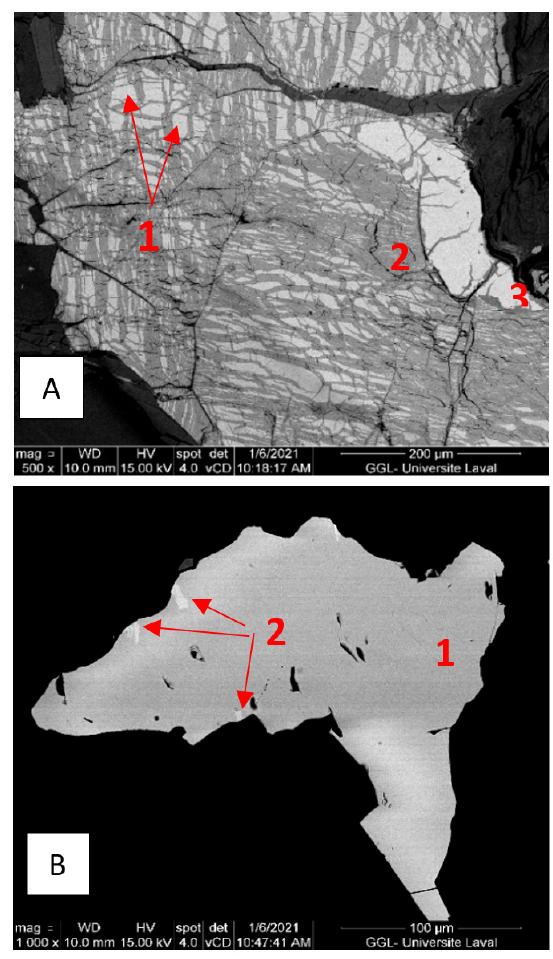
Figure 4. Secondary electron (SE) images of the sulfide from the Connecticut concrete sample. A) Strongly oxidized pyrrhotite grain. 1. pyrrhotite 2. ferrihydrite, 3. chalcopyrite. B) Pyrrhotite grain with pentlandite flames. 1. pyrrhotite 2.